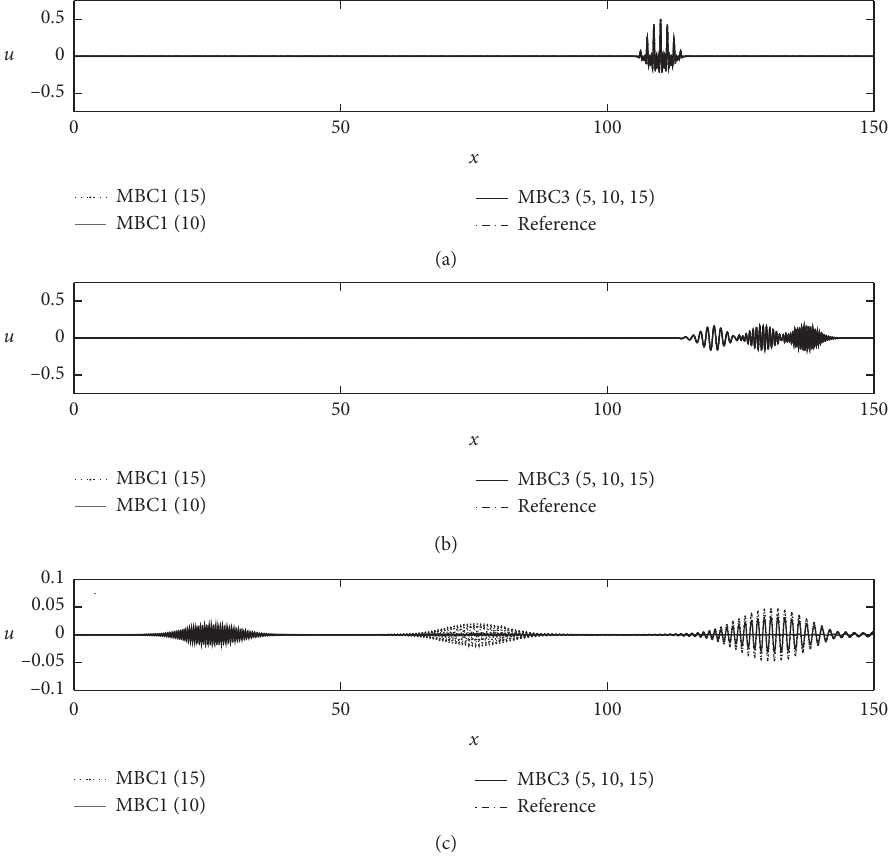
Figure 10: Time evolution of the waveform with three major wave numbers k � 5, 10, and 15: (a) (t) � 0, (b) t � 1.0, and (c) t � 6.0.